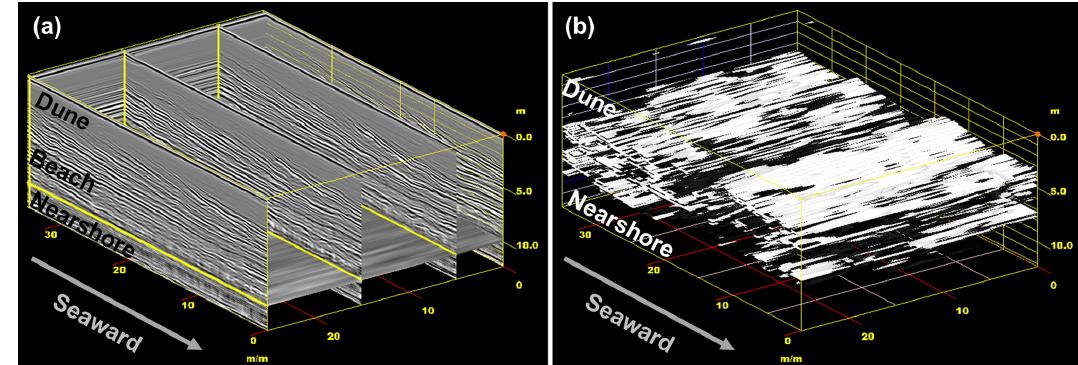
Figure 4. (a) Fence diagram showing some of the GPR transects collected in a grid configuration that identify barrier facies. (b) 3-D model of storm-eroded beachface stratigraphy constructed by isolating the most prominent reflections, shown in white, and interpolating between the transect lines. Figure modified from Dougherty